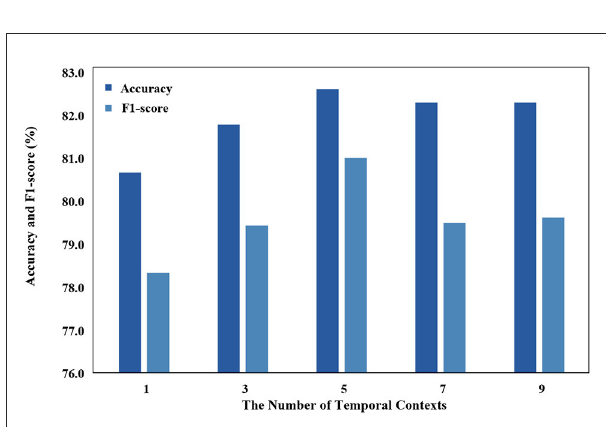
FIGURE6 Performance comparison of different graphs.